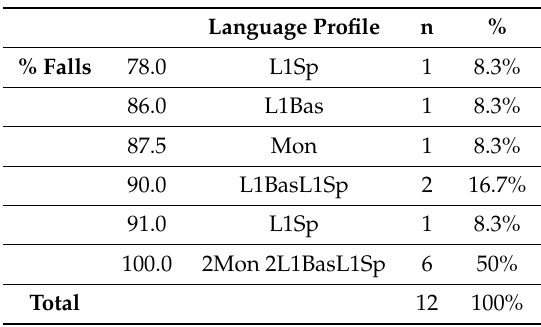
Table 6. Percentage of interrogative sentences ending in falling contours according to the speakers’ language profile 4 .